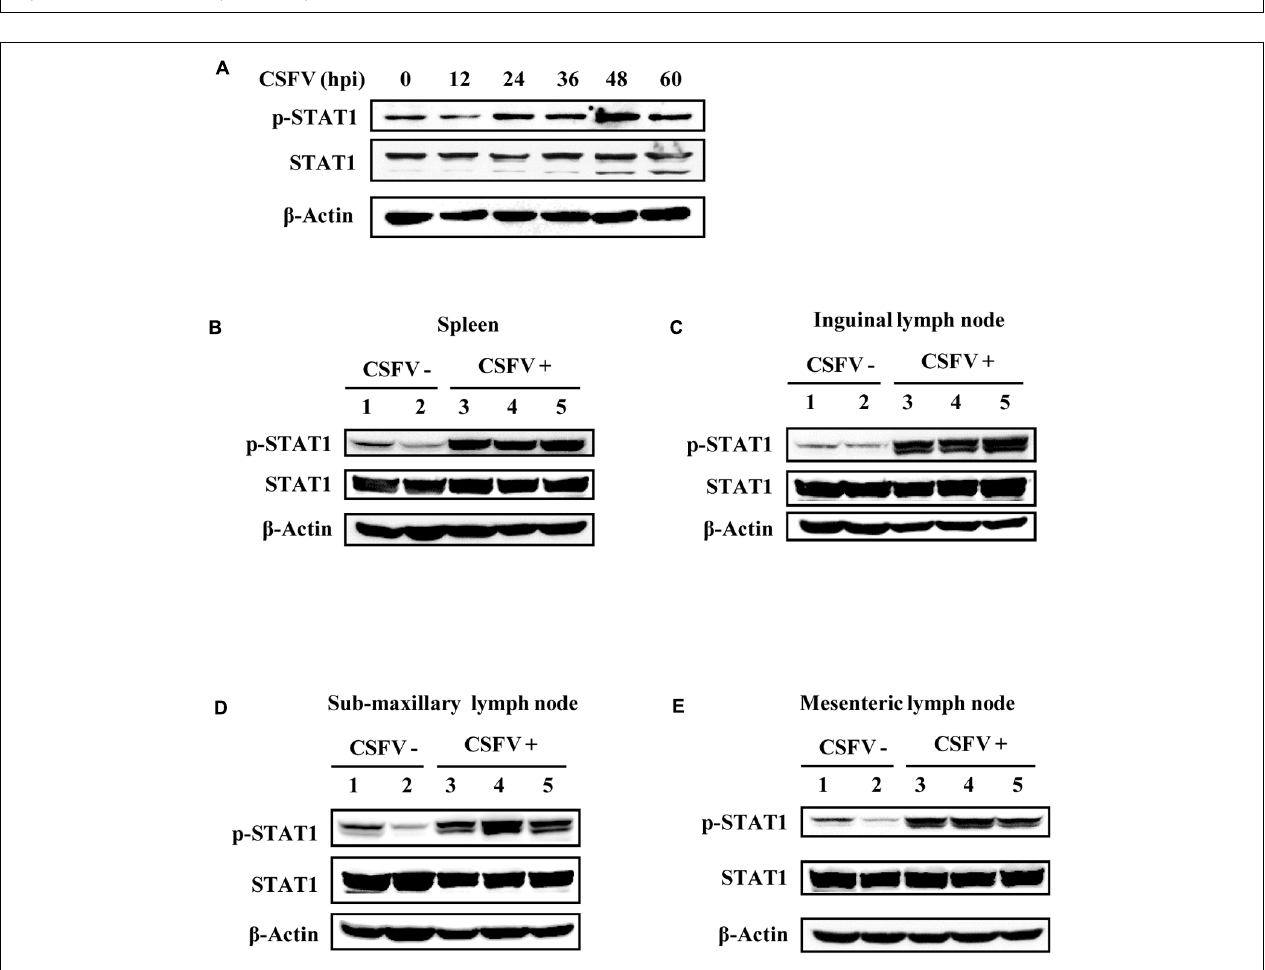
FIGURE 4 | STAT1 is activated by CSFV infection in vitro and in vivo . (A) PK-15 cells were infected with CSFV for indicated time, followed by analysis of Western blotting using indicated antibodies. (B–E) Pigs were infected with CSFV for 5 days as described in Figure 2 , followed by Western blotting using indicated antibodies. Expression of STAT1 and its phosphorylation status were examined in (B) spleen, (C) inguinal lymph node, (D) sub-maxillary node, and (E) mesenteric lymph node. Shown are representative of three independent